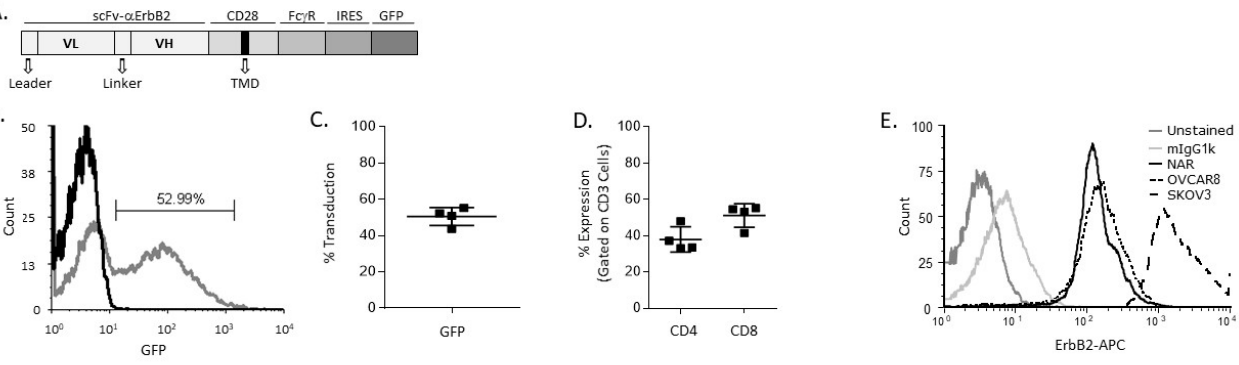
Figure 1. Characterization and in vitro activity of ErbB2CAR ‐ T cells : ( A ) The ErbB2CAR construct is comprises the ScFv specifically directed against ErbB2 followed by the co ‐ stimulation domain of CD28 and the activation domain from Fc γ R. ( B , C ): Retroviral supernatant collected from ErbB2 ‐ expressing packaging cells (PG13) was used to infect PBLs from a healthy donor. Infected and non ‐ infected cell cultures were grown for an additional 3 days following transduction. On the day they were harvested, the cells were analyzed by flow cytometry and the CAR expression level was cal ‐ culated. ( B ) A representative flow cytometry analysis of lymphocytes transduced with ErbB2CAR ‐ GFP. ( C ) Average transduction expression of the ErbB2CAR ‐ GFP. The dots indicate four independ ‐ ent experiments, and the lines show mean ± STDEV. ( D ) Expression of CD4/CD8 gated from CD3 positive cells out of ErbB2CAR ‐ GFP transduced T cells. Transductions of four donors are shown; a line indicates the average. ( E ) Expression of ErbB2 antigen on the human OC cell lines NAR, OVCAR8, and SKOV3. Cells were stained with anti ‐ human ErbB2 ‐ APC or mouse IgG1k ‐ APC iso ‐ type control and analyzed by flow cytometry. ( F ) Killing assay using effector (E) and target cells (T). Cells were incubated for 16 h with ErbB2CAR or UNT T cells (as control) at different E:T ratios as indicated. The percentage of killing was measured by methylene blue colorimetric assay. An aver ‐ age of five ErbB2CAR versus UNT experiments are presented with ± SEM. * p < 0.05; ** p < 0.01. ( G ) T cells transduced with ErbB2CAR (black bars) or UNT cells (gray bars) were co ‐ cultured with the indicated ovarian cell lines at an E:T ratio of 2:1. After 16 h, IFN γ levels in culture supernatants were measured by ELISA. The results shown are the average of three experiments ±STDEV. ErbB2CAR versus UNT * p < 0.05; ** p < 0.01. F/G statistical analysis was performed using Student’s t ‐ test be ‐ tween ErbB2CAR versus UNT treatment. 2.4. Preparation of Packaging Cells The 293T cells were transfected by Ca 2 PO 4 with a GAG ‐ POL pCL ‐ Ampho retroviral envelope [19] and the pBullet ‐ ErbB2 ‐ GFP. The retroviral supernatant was collected and used to stably transduce the amphotropic PG13 packaging cells. Infected cells were sorted by a BD FACS Aria III Cell Sorter to enrich CAR ‐ expressing cells, after which sorted cells were expanded and frozen in aliquots. 2.5. T ‐ Cell Transduction Retroviral transduction of T cells was performed as previously described elsewhere [20].